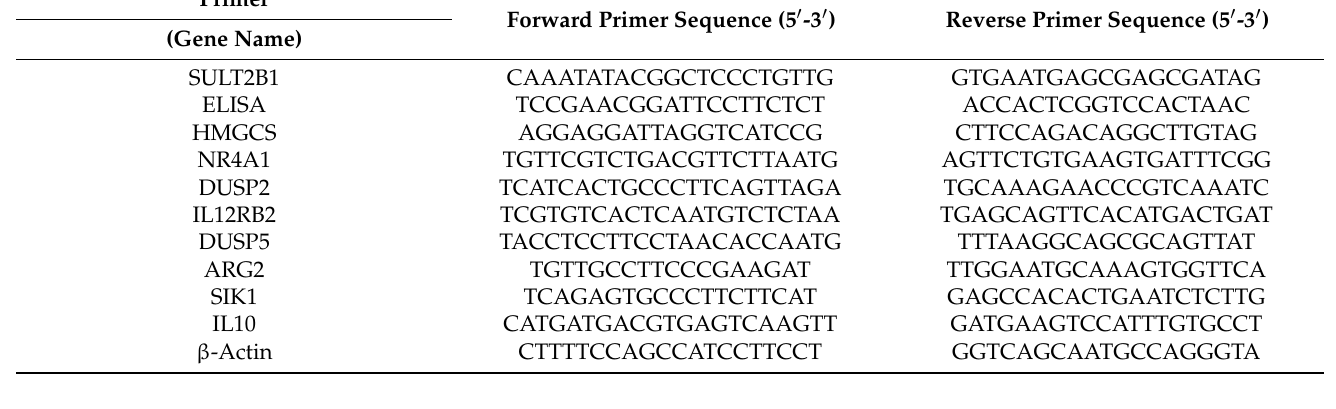
Figure 5 . Analysis of KEGG pathway enrichment of DEGs in FWG vs. BWG; FWK vs. BWK. Top 20 KEGG pathways ( p ≤ 0.05) for ( A ) FWG vs. BWG group; ( B ) FWK vs. BWK group (enrichment factor equals the ratio between the DEGs and all annotated genes enriched in the pathway). Each bubble’s color and size represents the significance of enrichment and the number of DEGs enriched in a pathway, respectively. Table 2. Primer sequences for qRT-PCR verification.